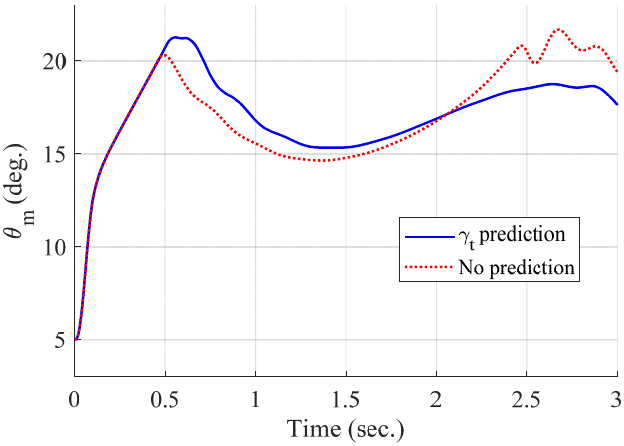
Figure 10. Pitch angle of the missile (single-run simulation).